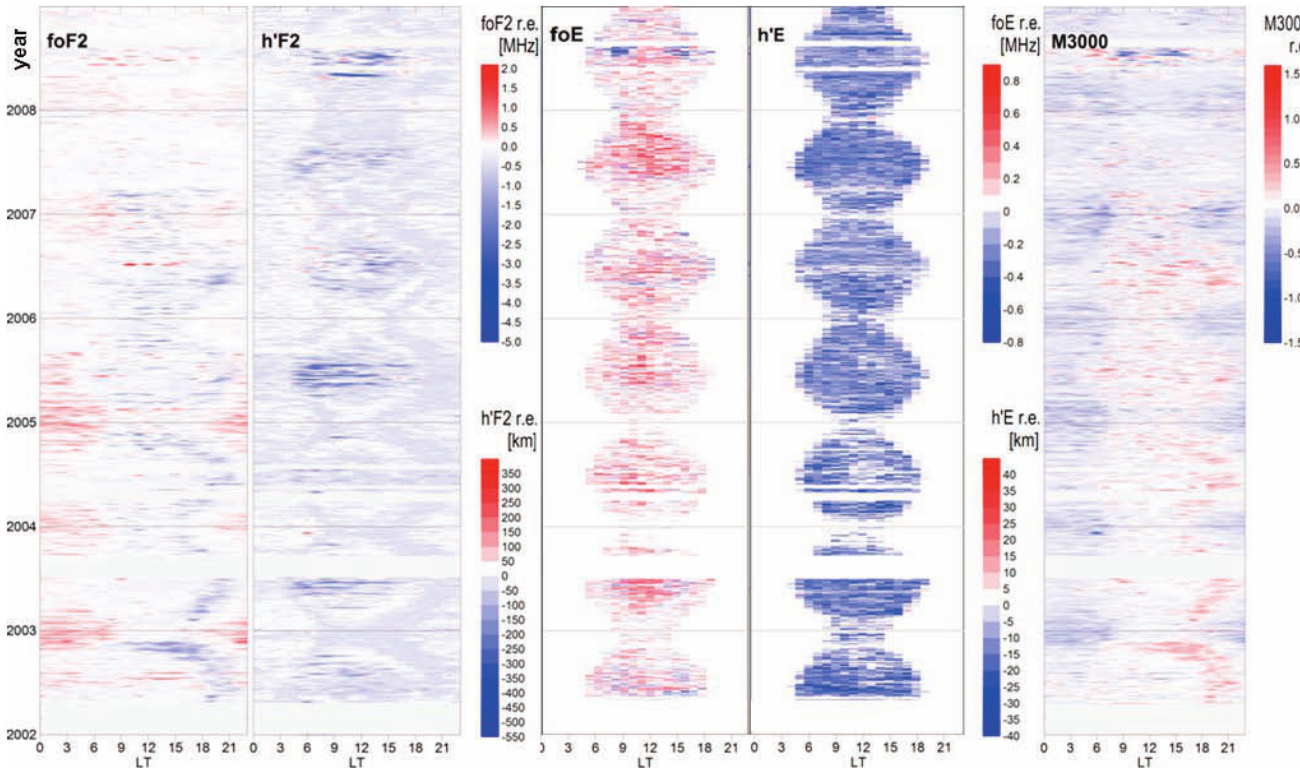
Figure 7. Contour plots of the annual and diurnal variations in the residual errors (automatically minus manually scaled values) for the foF2, h’F2, foE, h’E, and M(3000)F2 characteristics during the period of 2002 to